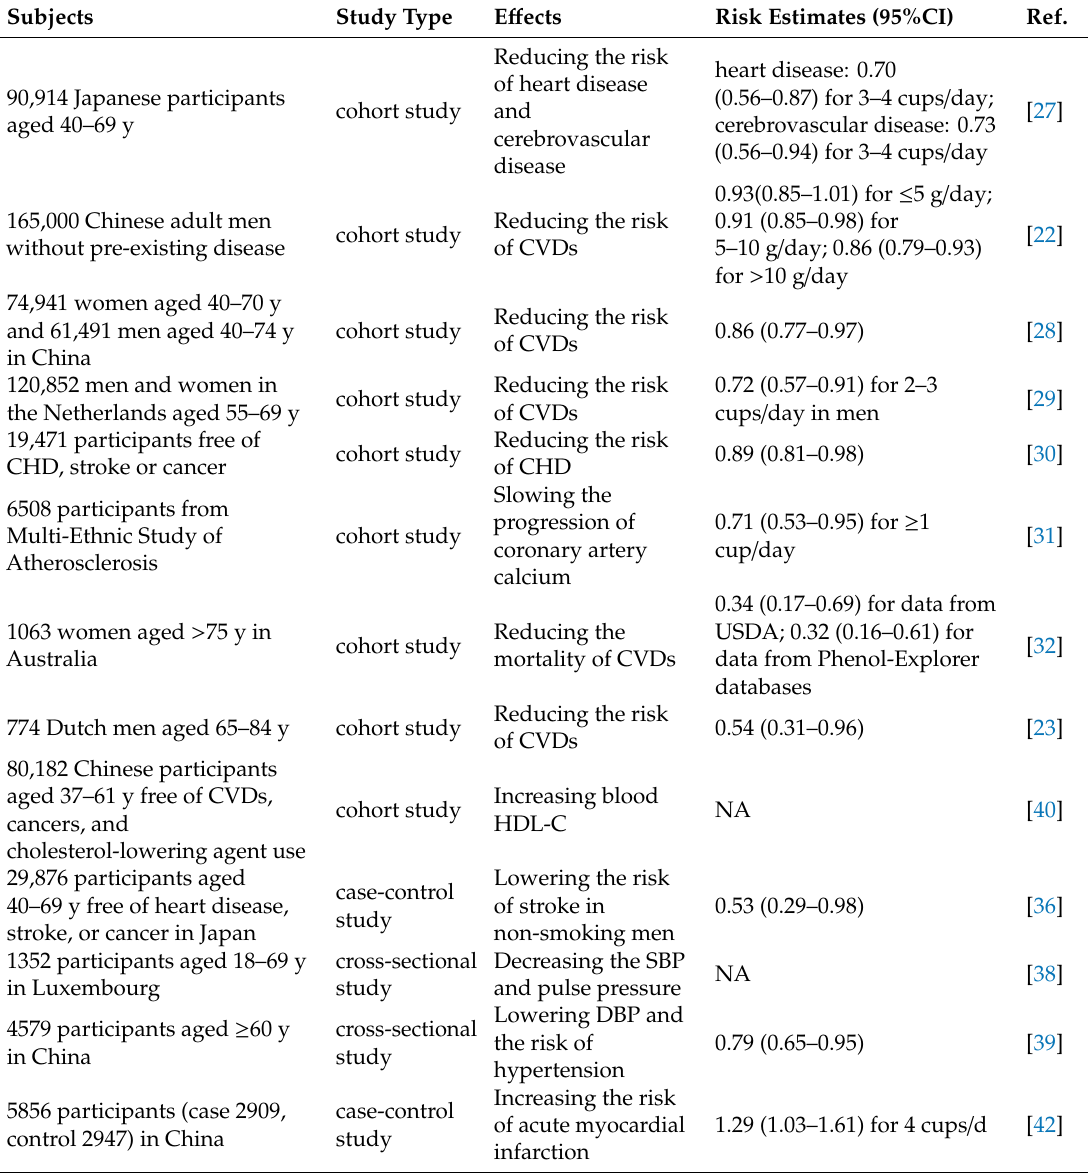
Table 1. The e ff ects of tea on CVDs based on epidemiological